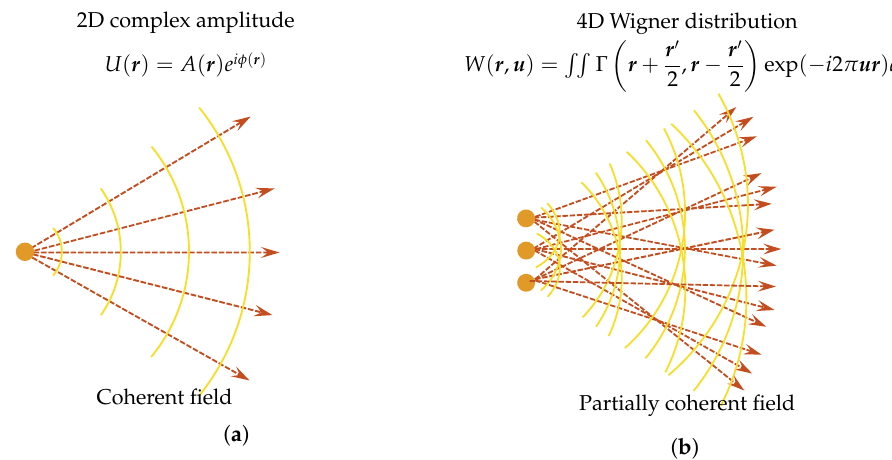
Figure 20. Schematic of a simplistic view of coherent field and partially (spatially) coherent field. ( a ) for coherent field, the surface of the constant phase is interpreted as wavefronts with geometric light rays traveling normal to them. It is fully described by 2D complex amplitude; ( b ) partially coherent field needs 4D coherence function, like the Wigner distribution, to accurately characterize its properties, like its propagation and diffraction. In addition, a partially coherent field does not have a well-defined phase, but rather a statistical ensemble of phases (spatial frequencies, propagation directions) at every position in